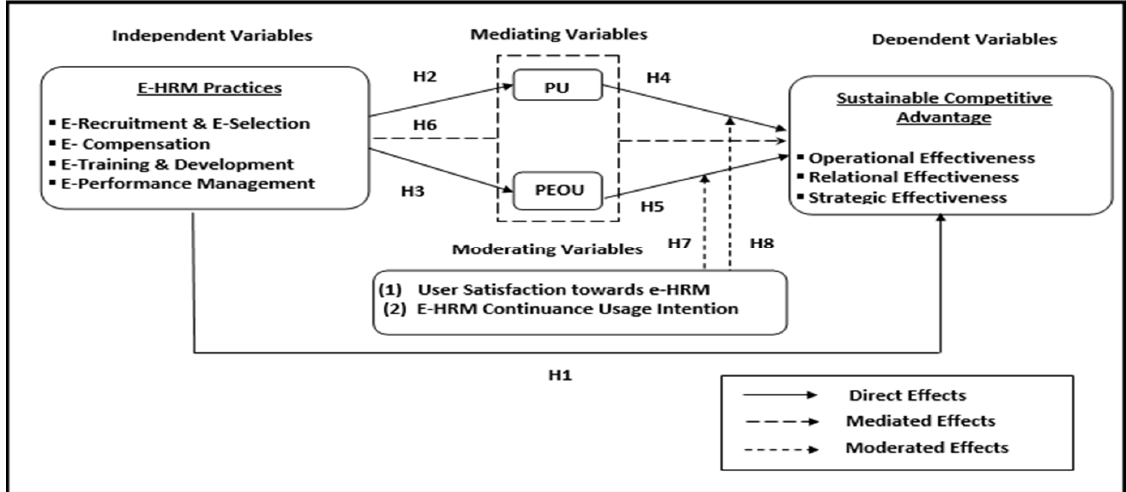
Fig. 1. The Proposed Model of the